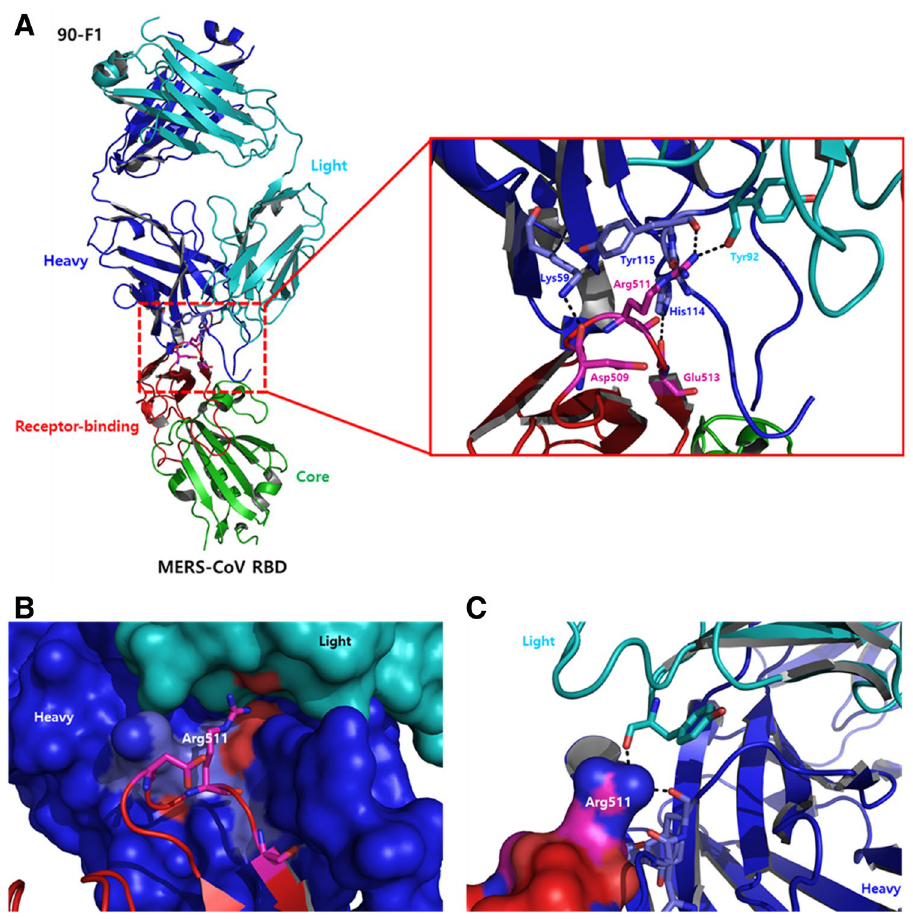
Figure 3. Epitope region of MERS-CoV RBD in a complex with KNIH90-F1 Fab. ( A ) Asp509, Arg511, and Glu513 in RBD are key residues binding residues in the heavy and light chains of KNIH90-F1 Fab. ( B , C